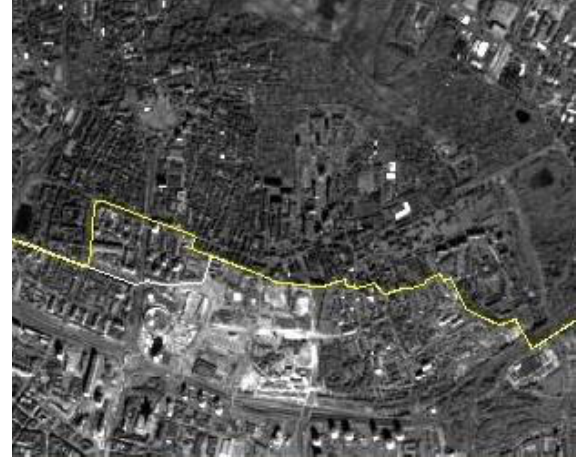
Figure 1. Part of the seamline in the city of Katowice